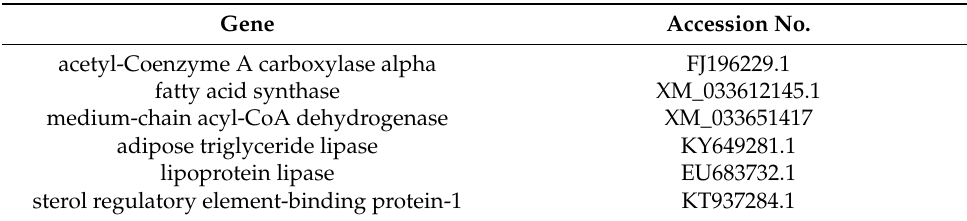
Table 2. GenBank accession numbers of genes used in this